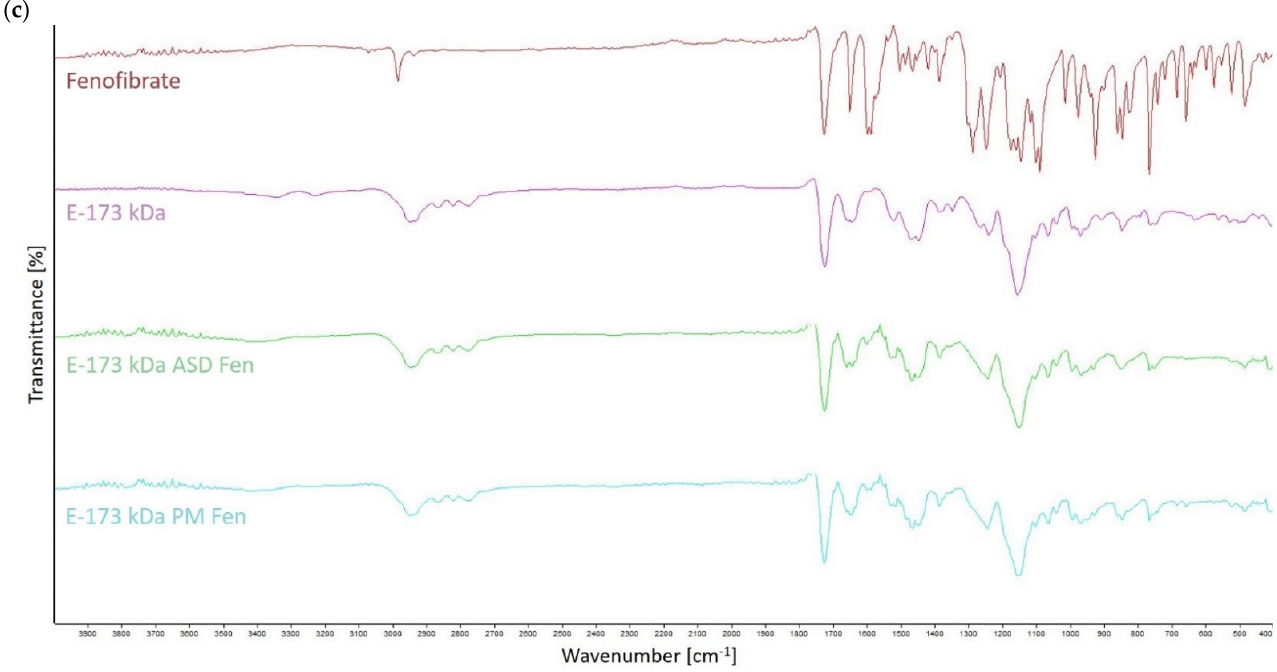
Figure 5. Fourier-transform infrared (FT-IR) spectrogram overlays of celecoxib ( a ), efavirenz ( b ), and fenofibrate ( c ), plotted together with E-173 kDa, a physical mixture (PM) of the specific drug and E-173 kDa, as well as the corresponding ASD processed via hot melt extrusion (HME).